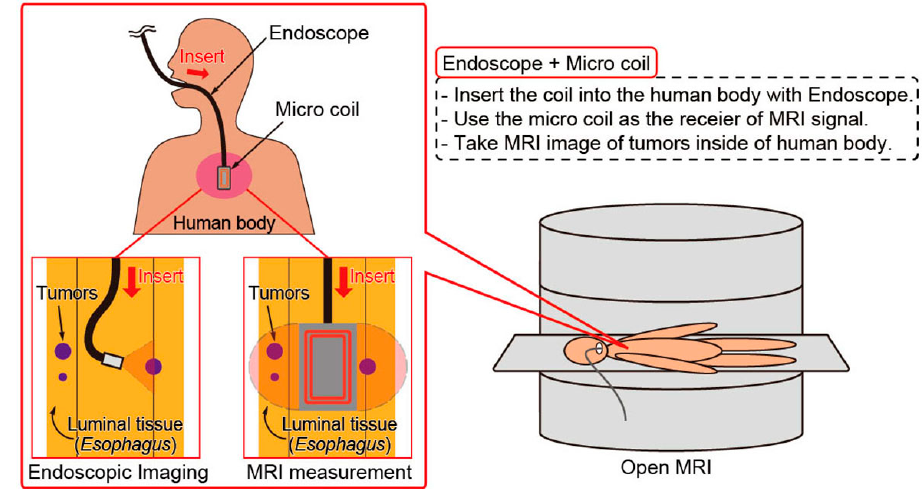
Figure 1. Concept of using the micro coil for magnetic resonance imaging (MRI) inside of the human body. By using a combination of endoscope and the micro coil, not only surface tumors but also small deep tumors in luminal tissue can be detected.